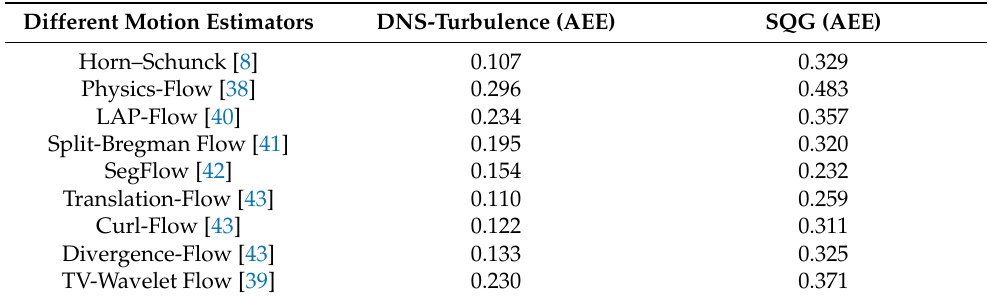
Table 1. Evaluation results of different motion estimators on the public fluid datasets. Different Motion